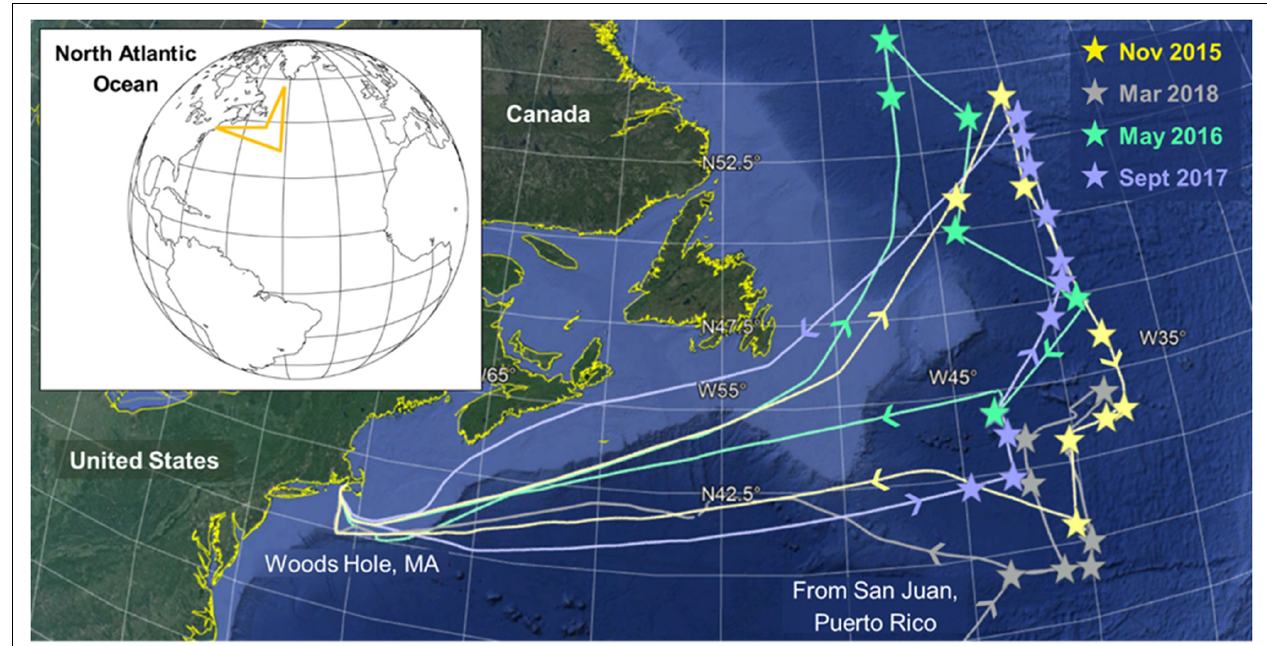
FIGURE 1 | Cruise tracks and station locations (stars) in the Western North Atlantic Ocean during the four North Atlantic Aerosols and Marine Ecosystem Study (NAAMES) field campaigns. The main sampling intensives occurred along a north-to-south transect at approximately 40 ◦ W. During March 2018, we departed from San Juan, Puerto Rico instead of Woods Hole, MA, United